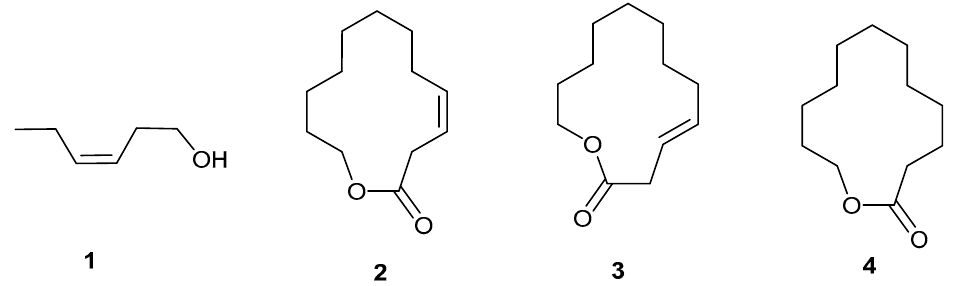
Figure 1. Green Leaf Alcohol and Macrolide EAB pheromones.